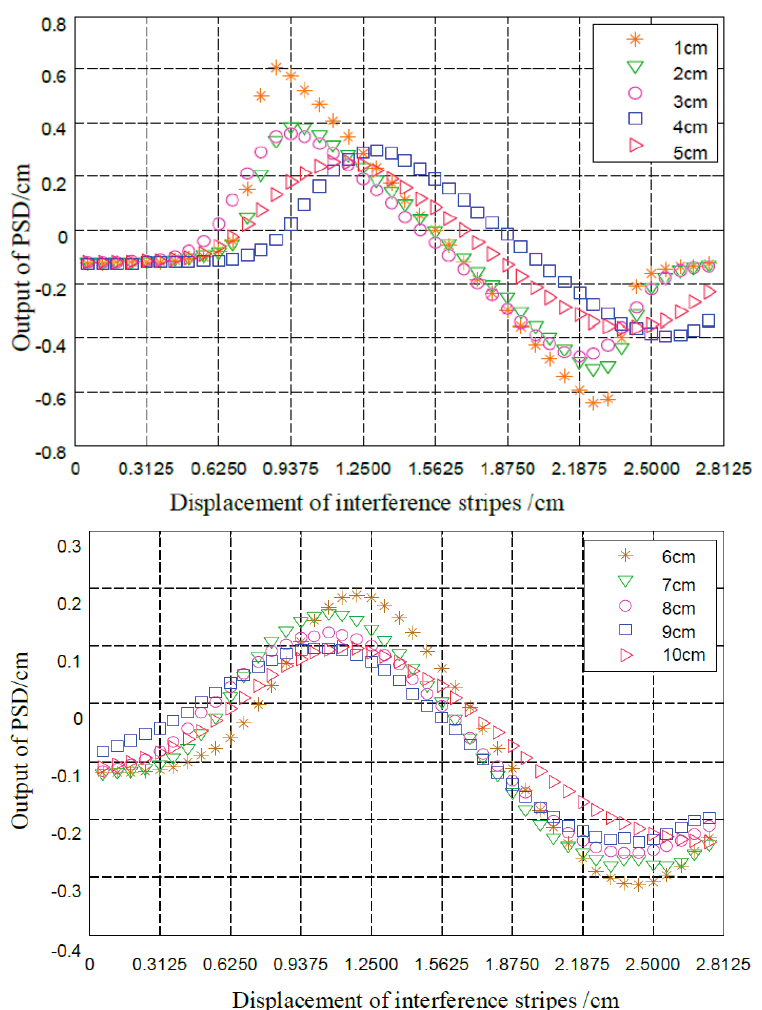
Figure 7. The characteristic curves of the